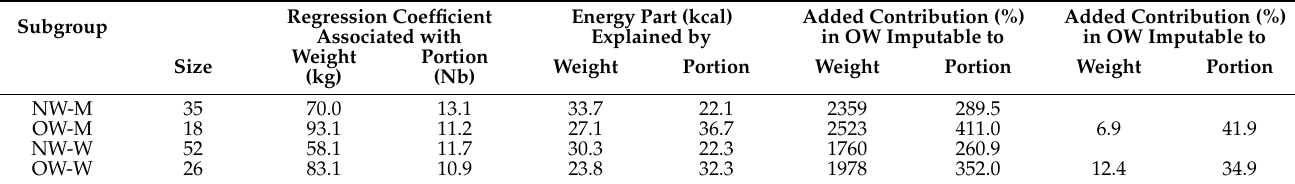
Table 3. Mean energy contribution estimated from weight and the number of food portions observed in the training group. (Mean weight and number of portion and values of regression coefficients for body weight and portion according to gender and weight